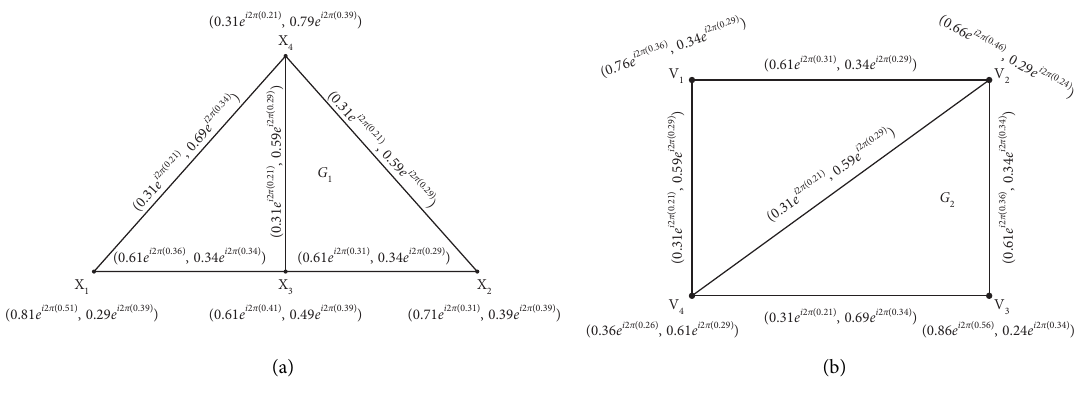
Figure 9: The two graphs shown are coweak